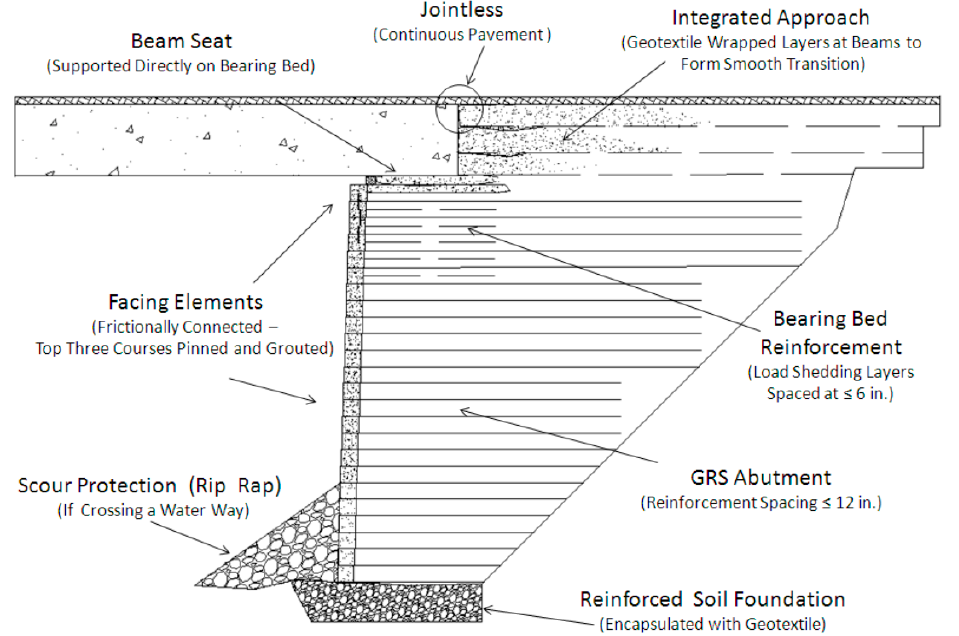
Figure 1. Typical GRS—integrated bridge system [8].